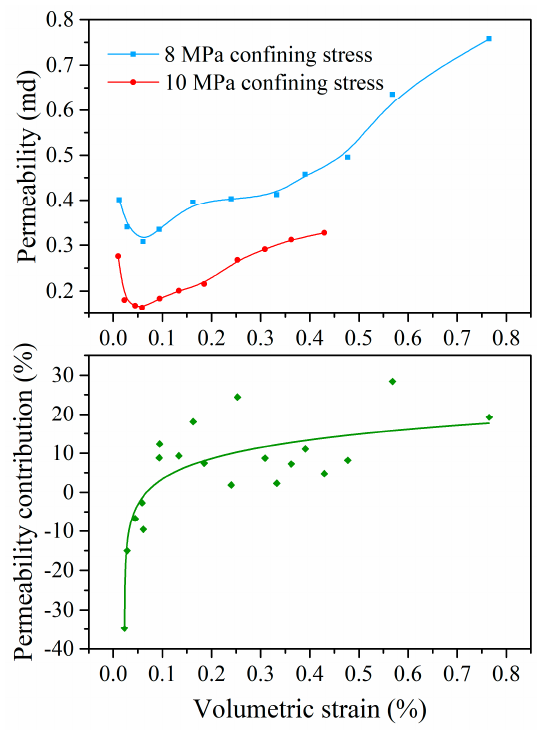
Figure 14. Sub-critical CO 2 permeability and permeability contribution versus the volumetric strain.